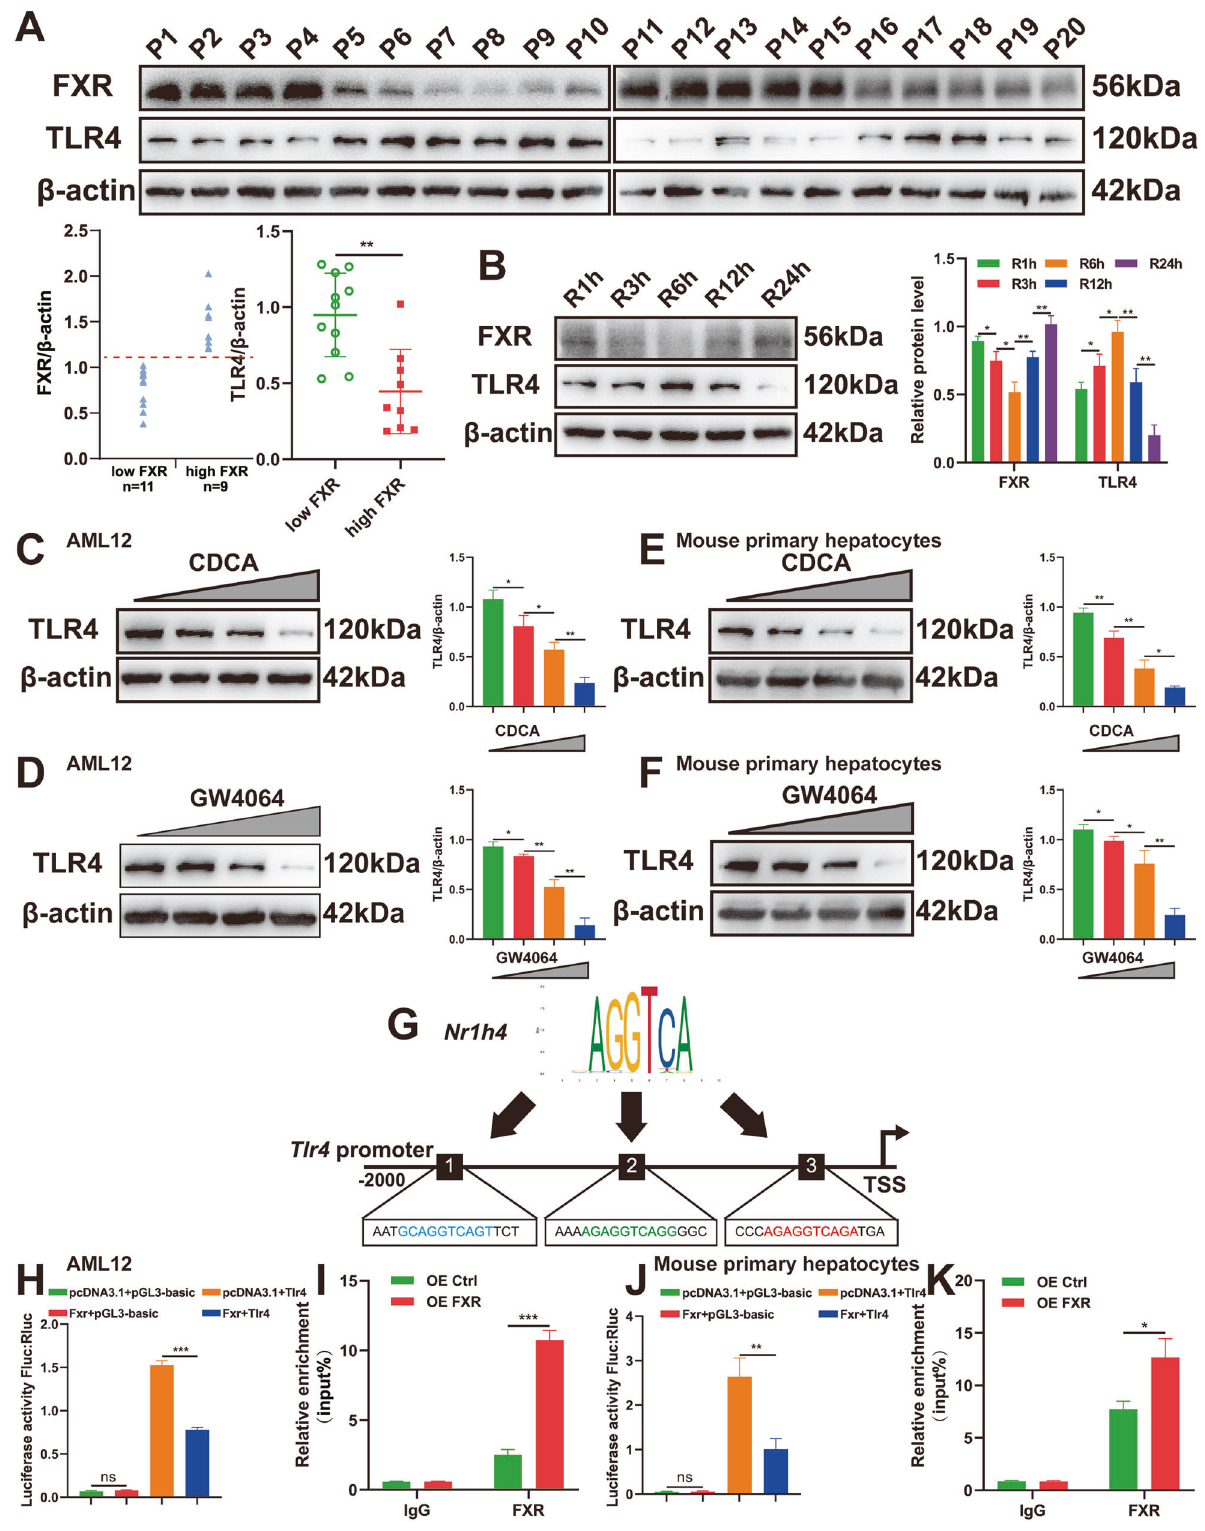
Fig. 6 FXR suppresses TLR4 transcription by directly binding to the FXRE located in the TLR4 promoter region. A Western blotting analysis of FXR in 20 clinical benign surgical liver samples. B The expression of hepatic FXR and TLR4 at the protein level in mice with different reperfusion durations. C , D , E , F Two types of FXR agonizts suppressed TLR4 expression in a dose-dependent manner in AML12 cells or mouse primary hepatocytes. G The promoter region of the mouse TLR4 gene contained several FXREs. H , J Transfection of pGL3-mTLR4-prom in the presence or absence of pcDNA3.1-FXR in AML12 cells or mouse primary hepatocytes for 24 h, and the luciferase assay was then performed. I , K AML12 cells or mouse primary hepatocytes were transfected with FXR overexpression or control plasmids. ChIP analysis was performed with anti-FXR or IgG ( n = 3 per group). Data are the mean ± SEM, ∗ p < 0.05; ∗∗ p < 0.01; ∗∗∗ p < 0.001 by unpaired Student ’ s t test. Cell Death and Disease (2022)